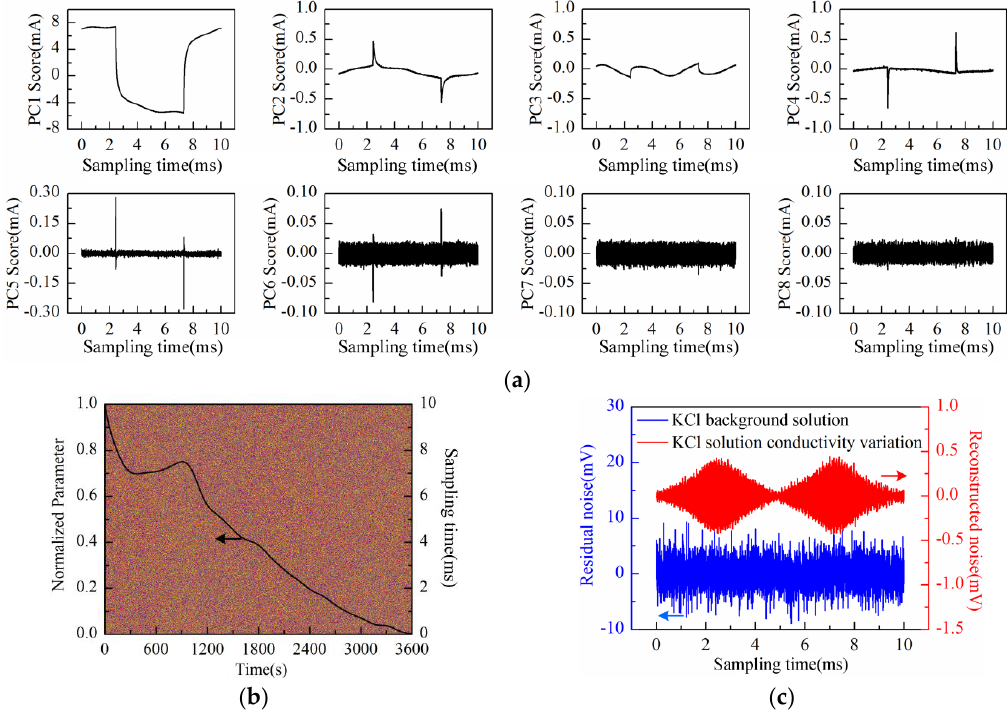
Figure 10. Measurement results of the KCl background solution conducted with Au-IDT: ( a ) PC1–PC8 scores plot; ( b ) PC1 loading curve (after SSA) and the residual noise image; ( c ) The residual noise signal at 360 s.